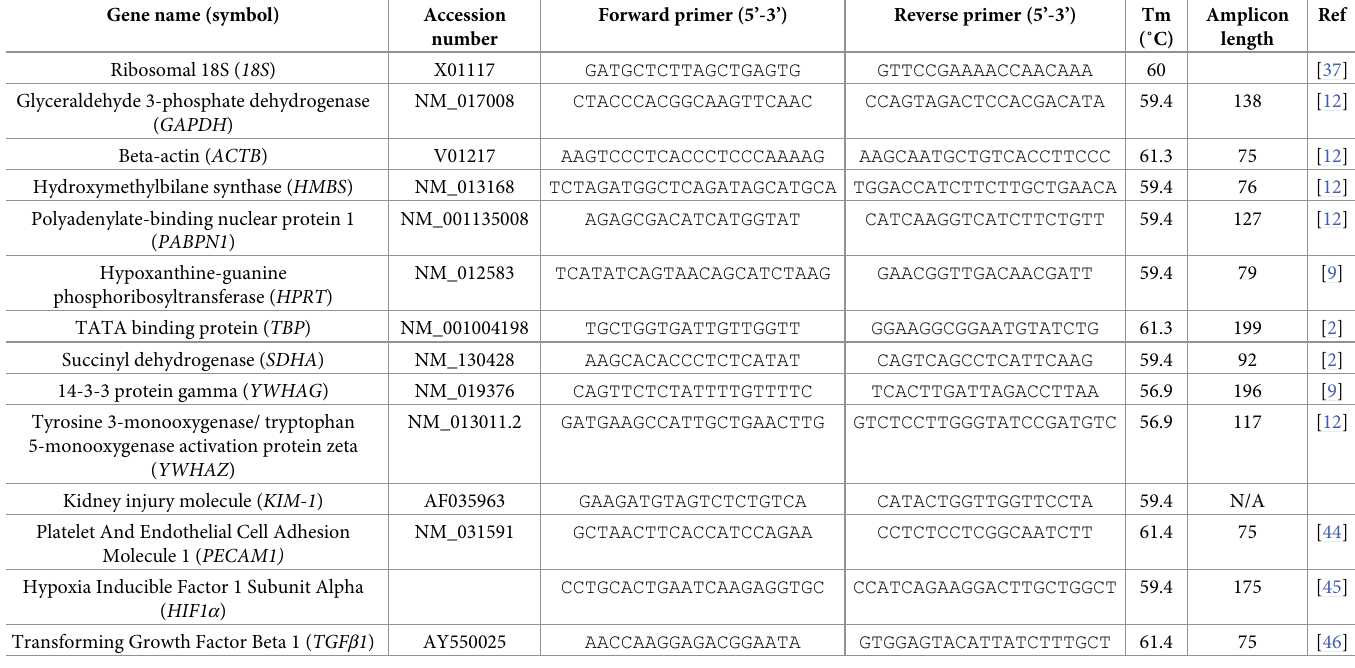
Table 16. Reference genes and GOI